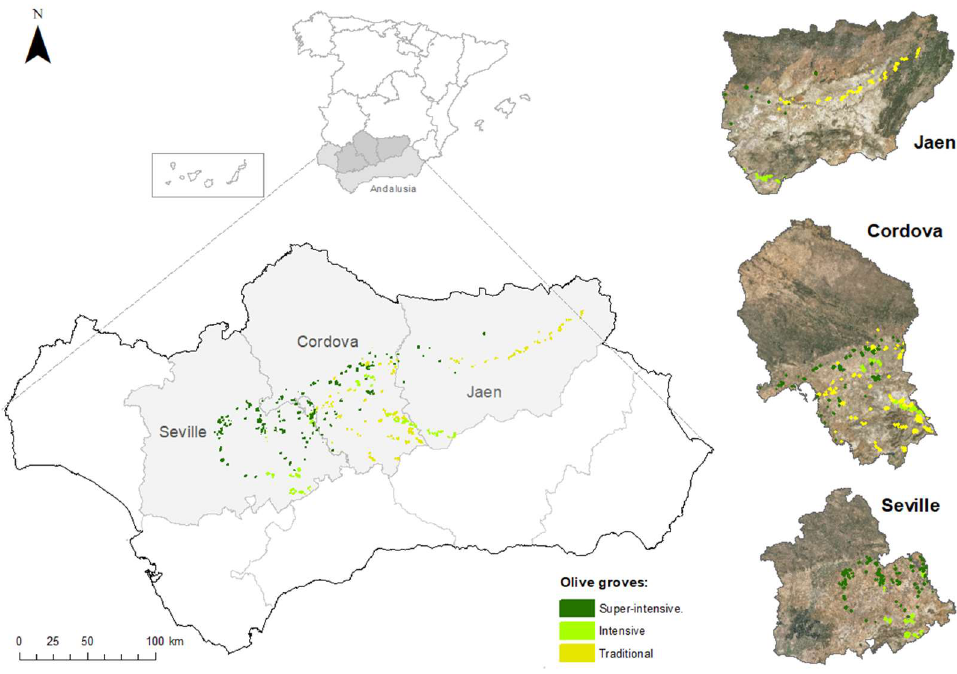
Figure 1. Location of the study area in Andalusia, southern Spain.